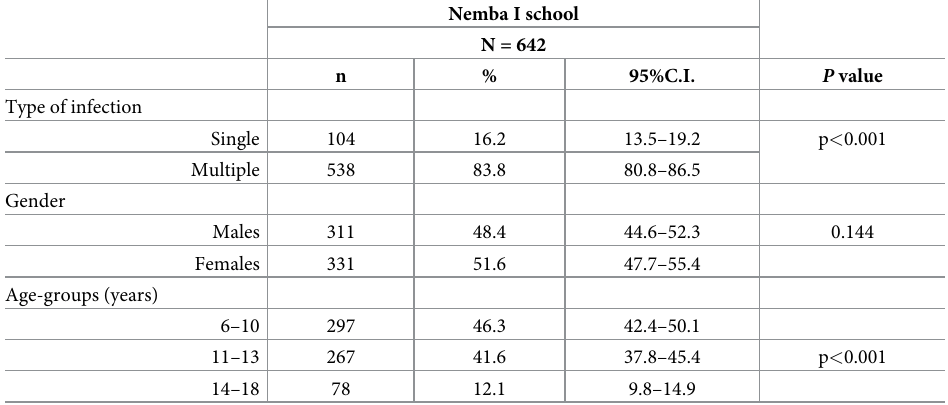
Table 3. Infection distribution (%) according to type of infection and demographic characteristics (gender and age-groups).